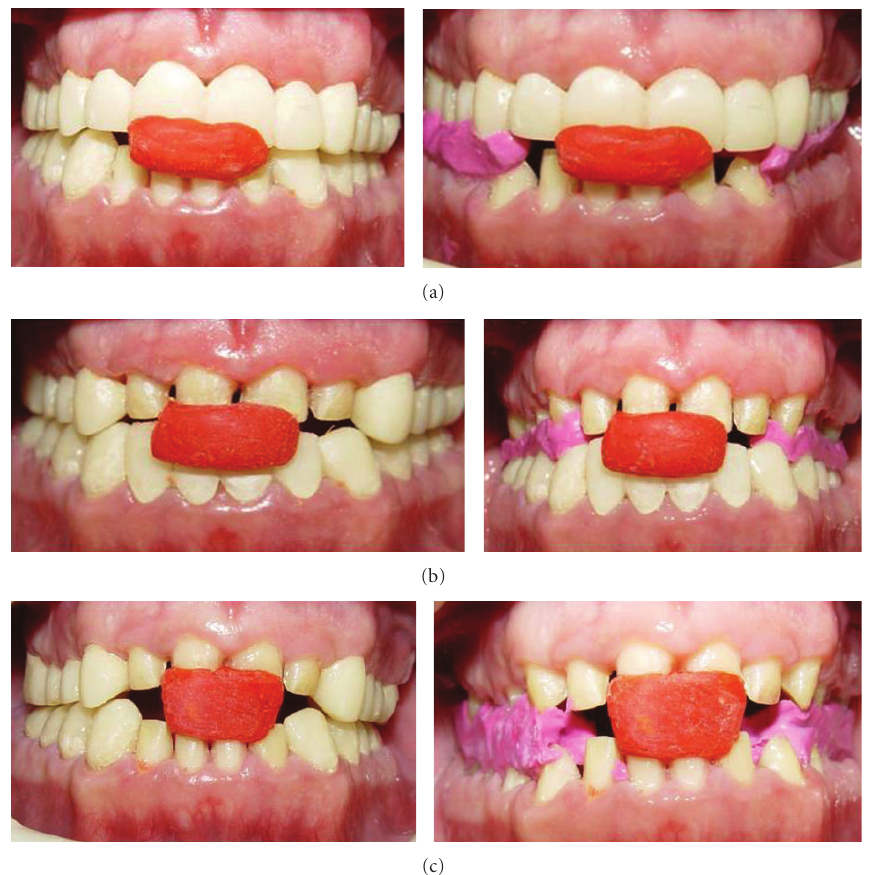
Figure 7: Records for cross-mounting: (a) record of maxillary provisional restorations in relation to mandibular prepared teeth; (b) record